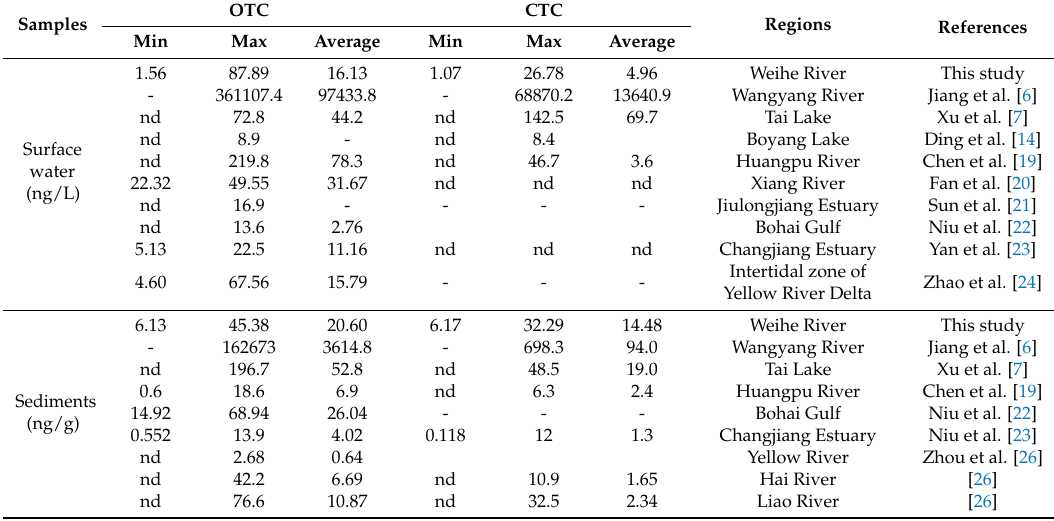
Table 2. Residual levels of tetracyclines in surface water and sediments in different